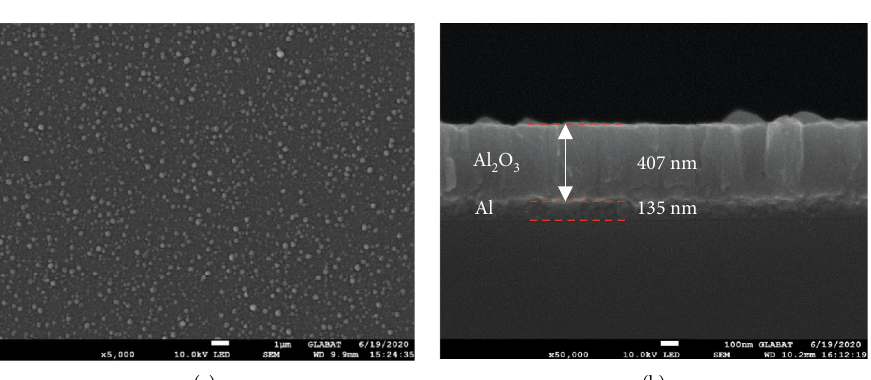
O composite coating: (a) surface and (b) cross-sectional. 2 3